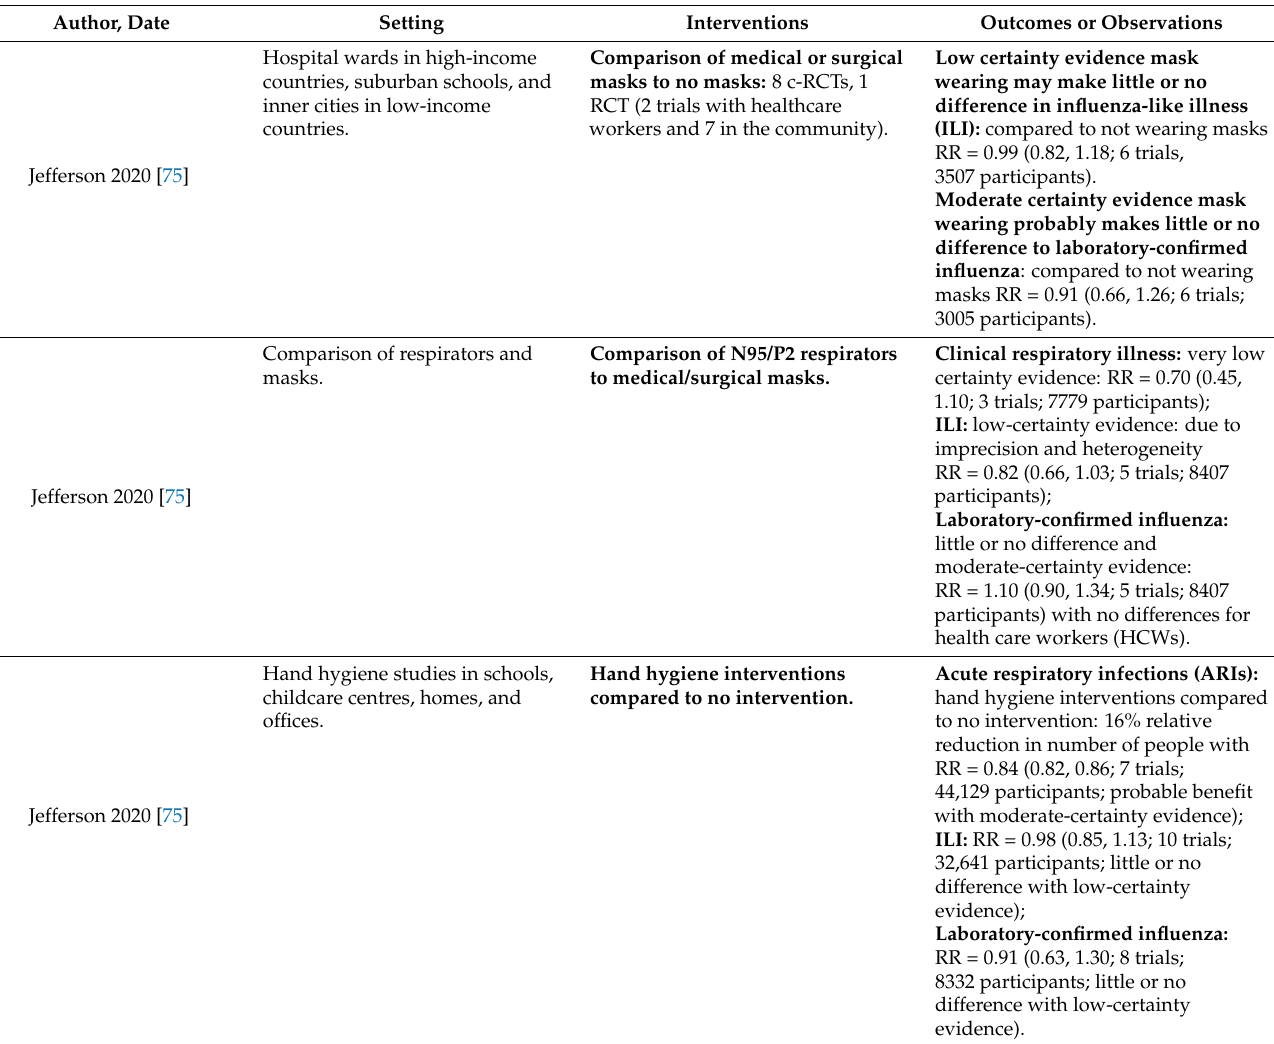
Table 8. Interventions to decrease respiratory disease transmission using masks, hand washing, isolation rooms, decreasing surface contamination and identifying communities at risk. Interventions to Decrease Respiratory Disease Transmission Using Masks, Hand Washing, and